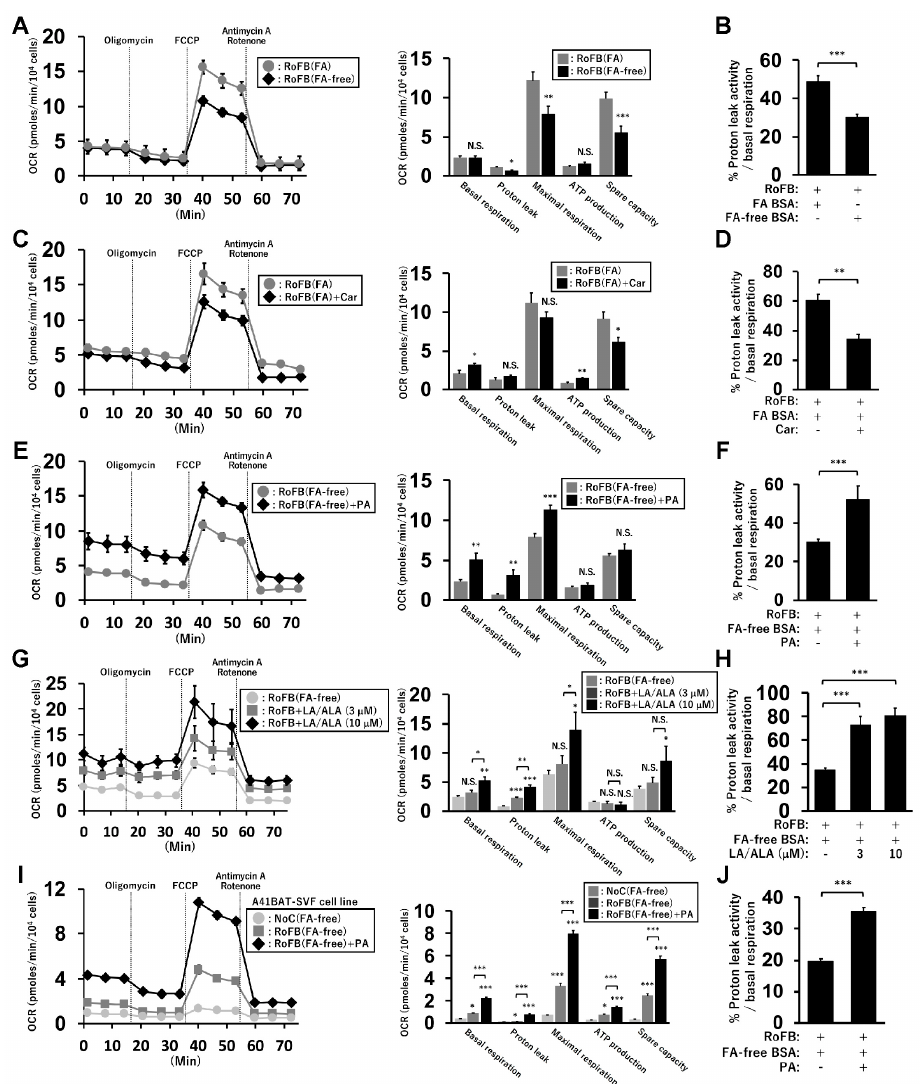
Figure 6. FA supply modulates mitochondrial proton-leak activity in ciBAs. ( A ) Oxygen-consumption rate (OCR) was measured using the flux analyzer in ciBAs, RoFB(FA) (gray circles), and RoFB(FA-free) (black diamonds). Oligomycin, FCCP, and antimycin A/rotenone were added during the measurement as indicated. Each OCR corresponding to basal respiration, proton leak, maximal respiration, ATP production, and spare respiratory capacity was calculated. ( B ) The percent ratio of the proton-leak activity to the basal respiration was compared. ( C , D ) OCR ( C ) and the percent ratio ( D ) were compared between RoFB(FA) (gray circles) and RoFB(FA) + Car (black diamonds). ( E , F ) OCR ( E ) and the percent ratio ( F ) were compared between RoFB(FA-free) (gray circles) and RoFB(FA-free) + PA (black diamonds). ( G , H ) ciBAs were treated with linoleic acid (LA) and α -linolenic acid (ALA) at 3 and 10 µ M, respectively. OCR ( G ) and the percent ratio ( H ) were compared in RoFB(FA-free) (light gray circles), RoFB + LA/ALA (3 µ M) (gray squares), and RoFB + LA/ALA (10 µ M) (black diamonds). ( I , J ) OCR ( I ) and the percent ratio ( J ) were compared in the A41BAT-SVF adipocytes differentiated under the same condition as ciBAs, NoC(FA-free) (light gray circles), RoFB(FA-free) (gray squares), and RoFB(FA-free) + PA (black diamonds). Data represent mean ± SEM ( n = 6–8). Student’s t -test: * p < 0.05, ** p < 0.01, *** p < 0.001, N.S.; not